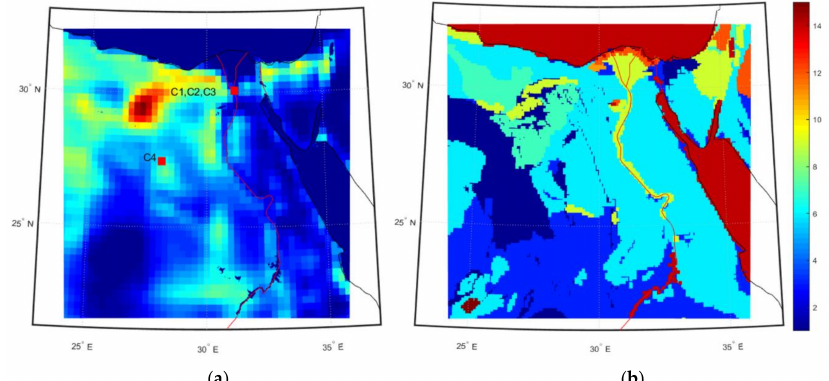
Figure 2. Spatial distribution of the erosion factor ( a ) and soil texture classification ( b ) over Egypt, used as input to the model. The 16 categories of the soil are presented in Table 5. Location of AERONET stations (C1, C2, C3 and C4) are indicated on the Figure 2a.